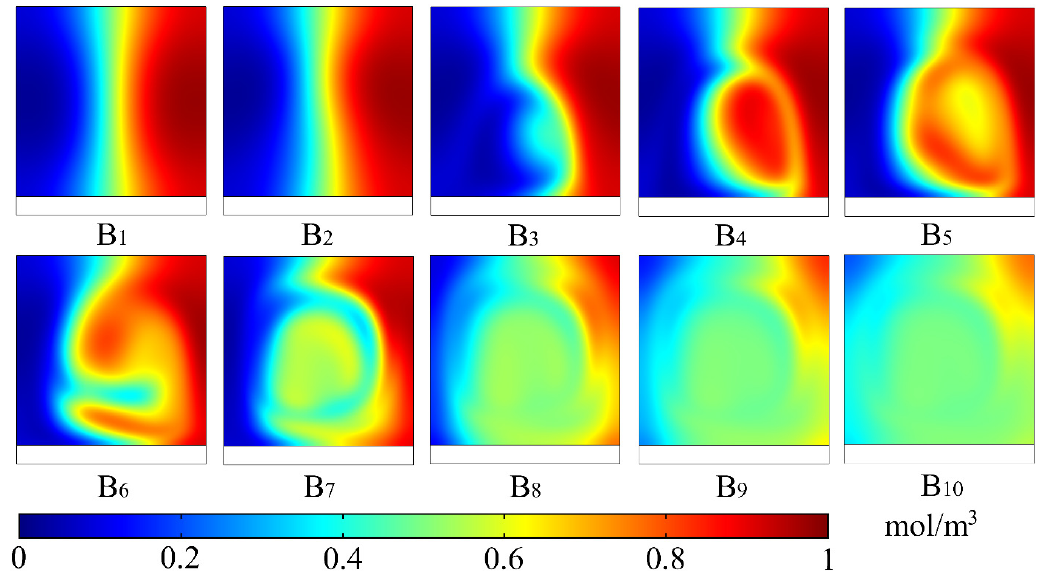
Figure 6. Concentration-distribution evolution of B–B cross-section (near the outlet) at 10 different moments in the microchannel during four cycles. B, cross-section; subscript i, different moments: ( B 1 ) t = 0 T, ( B 2 ) t = 1/4 T, ( B 3 ) t = 3/8 T, ( B 4 ) t = 1/2 T, ( B 5 ) t = 5/8 T, ( B 6 ) t = 3/4 T, ( B 7 ) t = 1 T, ( B 8 ) t = 2 T, ( B 9 ) t = 3 T and ( B 10 ) t = 4 T. Peak-to-peak value of applied potential was V 0 = 1 V, electric-field frequency was f = 5 Hz, and inlet mean velocity was U m = 2 × 10 –4 m/s. Length was L o = 10 μ m, width was W o = 10 μ m, and spacing was S o = 10 μ m of the virtual electrode. Aspect ratio of the microchannel was W c / H c = 1. Color legend, concentration distribution from 0 to 1 mol/m 3 .